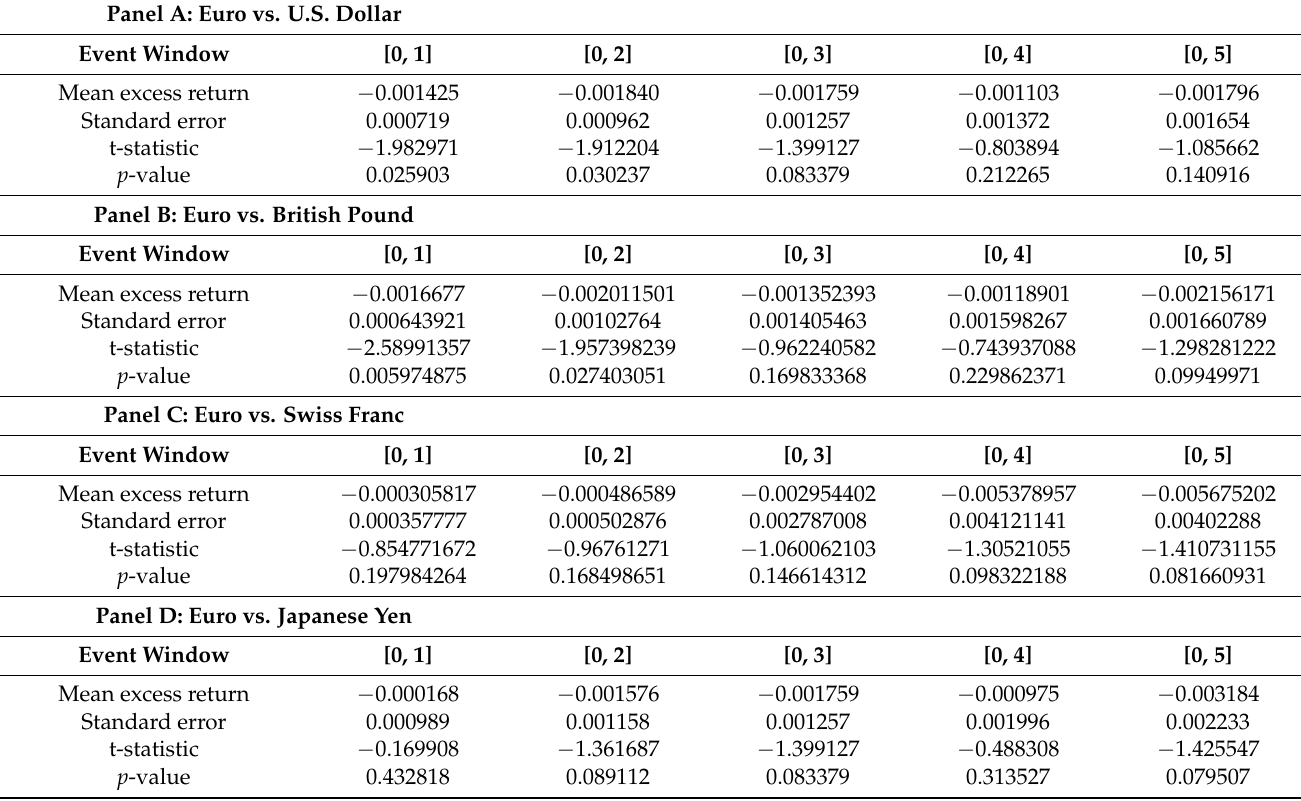
Table 3. Event-Study Results (full